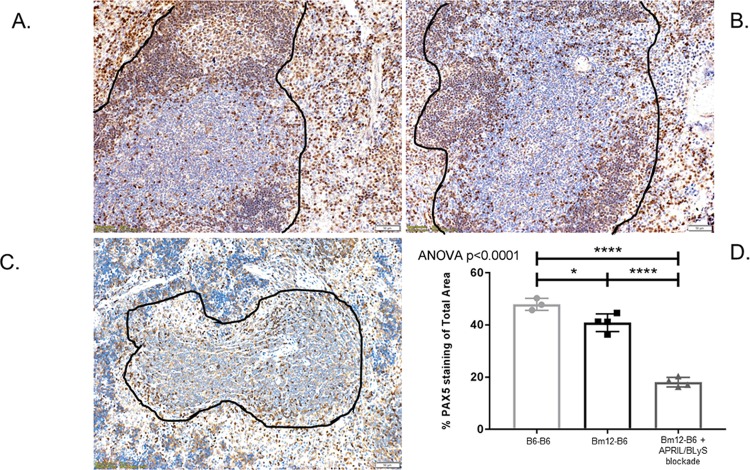
Spleen PAX5 significantly decreased in APRIL/BLyS blockade treated mice.Preservation of splenic germinal center seen in (A) syngeneic transplant control and (B) untreated transplant group. B lymphocytes are shown in brown; T lymphocytes are shown in blue. (C) Destruction of normal germinal center seen in animals treated with APRIL/BLyS blockade as indicated black outline. (D) Densitometry using anti-PAX5 antibody to detect B lymphocytes in splenic germinal centers. Graph depicts percentage of total area of spleen staining for anti-PAX5.